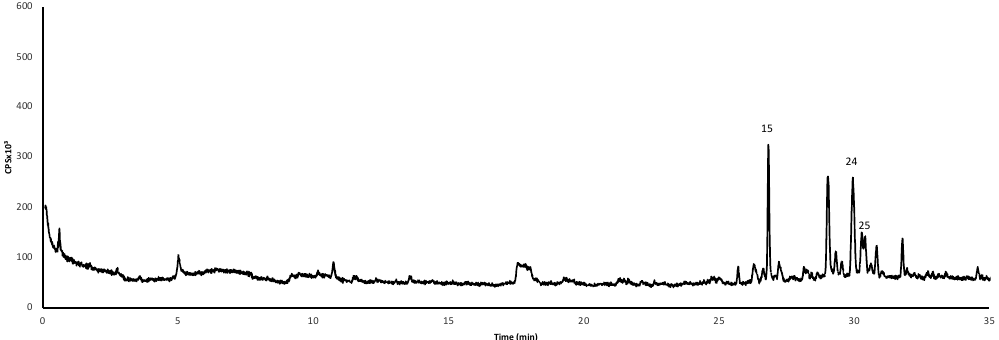
Figure 5. GC/MS chromatogram of VOC s emitted by petals of P. ‘Endsleigh’ flowers at full bloom. The peak numbers correspond to the compounds listed in Table 5.